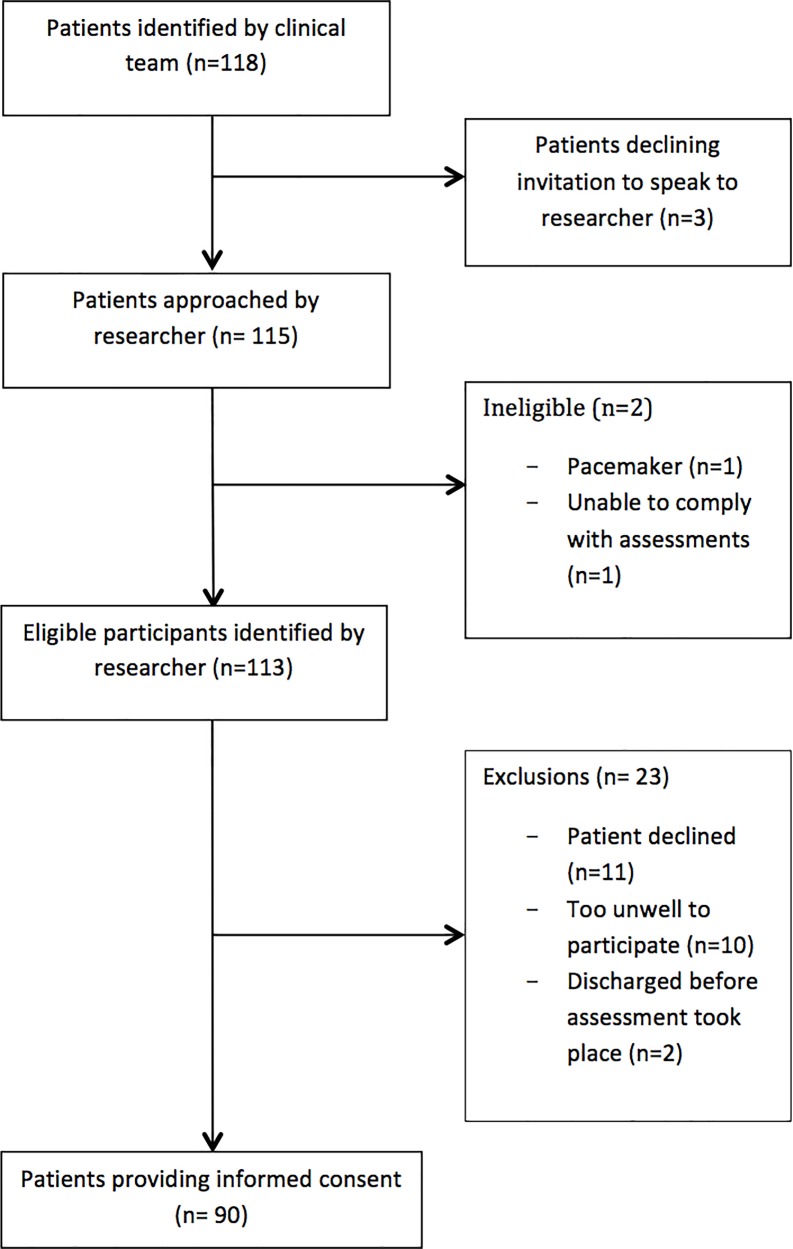
Recruitment flowchart.Flowchart representation of the number of individuals recruited to the study.